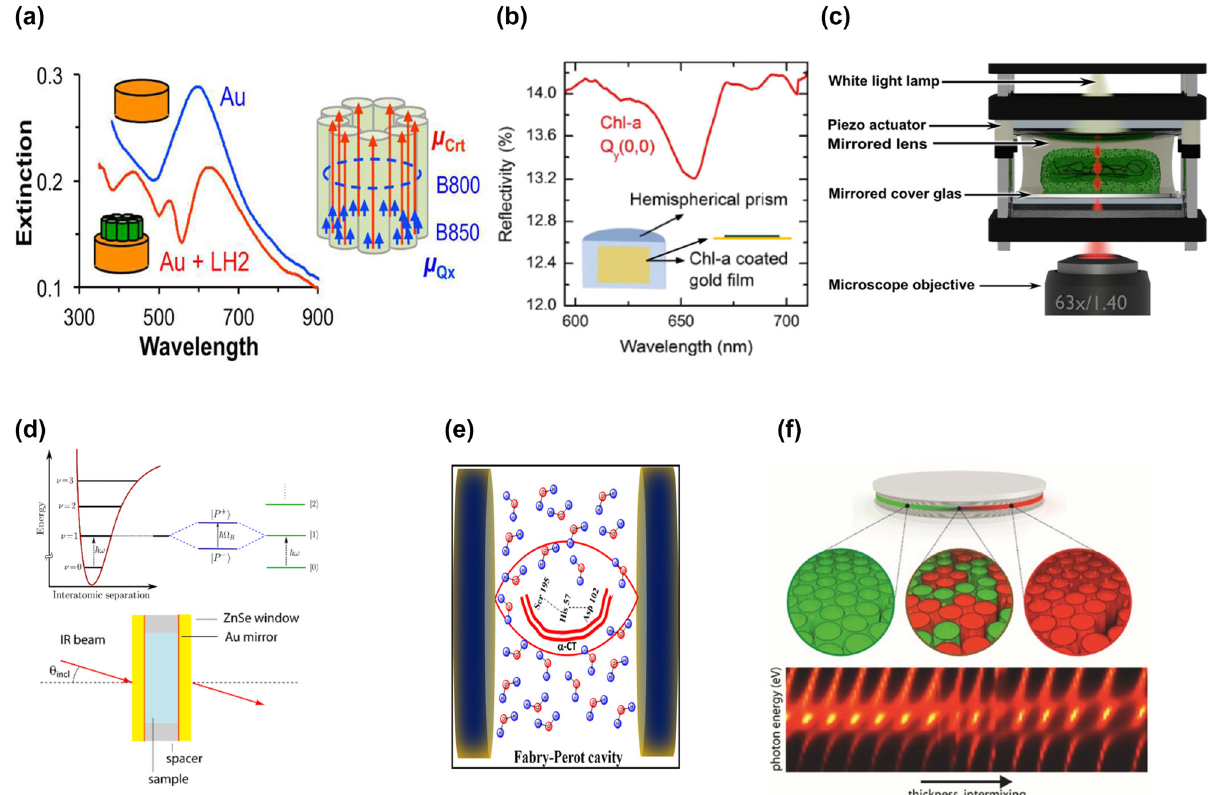
Figure 6: Applications of strong coupling in biophysics. (a) Extinction spectra for gold nanostructure (blue) and with LH2 (red), and transition dipoles. (b) Schematic diagram showing hybrid nanostructure schematic illustration of his-tagged LH2 with Crt and B850 Q x consisting of Chl-a and gold film on a hemispherical prism. At 656 nm, there is a dip in the reflectivity of Chl-a molecules. (c) Fabry–Pérot microresonator setup with cavity including two mirrors, piezoelectric actuators, and bacteria. (d) Schematic diagrams of energy level states for VSC with a protein (top) and experimental setup (bottom). (e) Sketch of Fabry–Pérot cavity resonator used to study the catalytic activity of enzyme α -CT under VSC of water. (f) Strong coupling scheme between a Fabry–Pérot cavity and fluorescent proteins (tdTomato and eGFP). The pictures are reproduced with permission: (a) Ref. [191] © 2016 American chemical society. (b) Ref. [169] © 2019 American chemical society. (c) Ref. [189] © 2021 the authors. (d) Ref. [86] © 2016 American chemical society. (e) Ref. [198] © 2020 American chemical society. (f) Ref. [199] © 2016 the